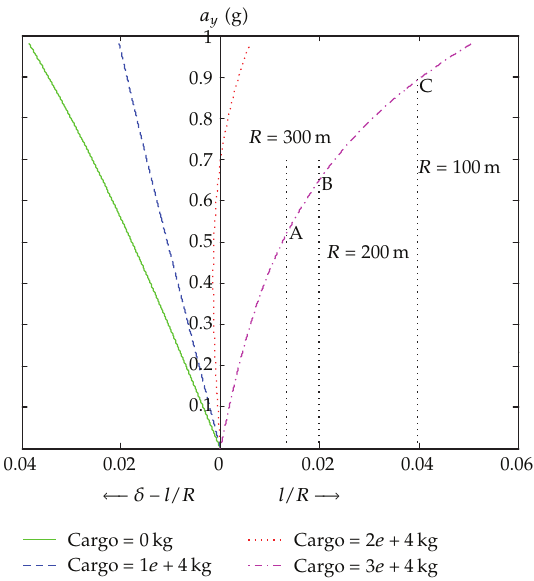
Figure 10: R -handling diagram for tractor semitrailer with one rear